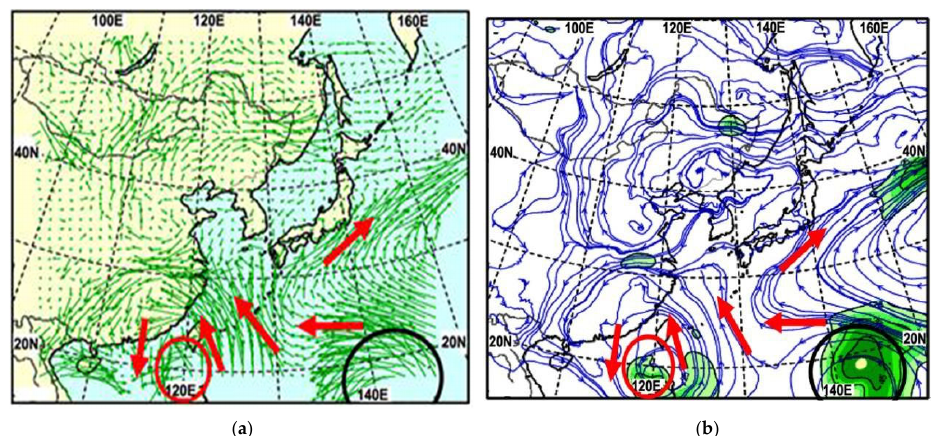
Figure 9. As shown in Figure 3, except for ( a ) surface pressure analysis (hPa) and ( b ) COMS ‐ IR. satellite image at 09:00 LST, 6 July 2015. The multiple interactions between STS Linfa and TY Chan ‐ Hom and between the MLTTC and TY Chan ‐ Hom decreased the distance between them.